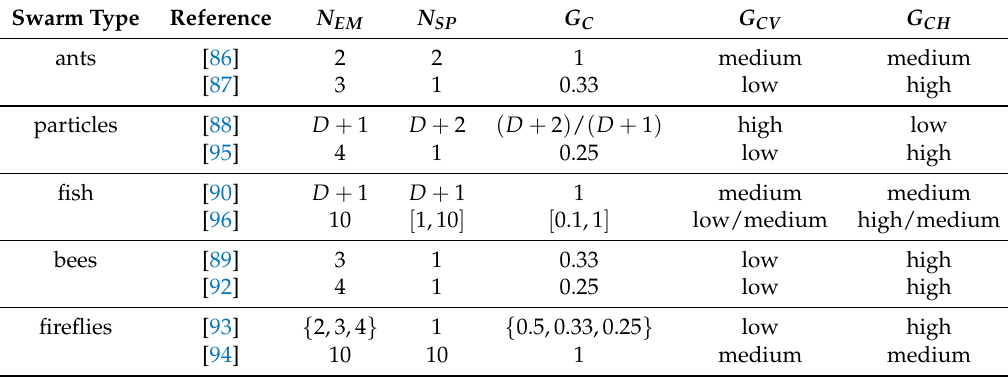
Table 4. Measure of cooperation degree for several multi-swarm methods ( N EM : Number of organisations that belong to the network; N SP : Number of products/services which the organisations offer; G C : Degree of cooperation; G CV : Degree of vertical cooperation; G CH : Degree of horizontal cooperation. For multi-objective problems D denotes the number of